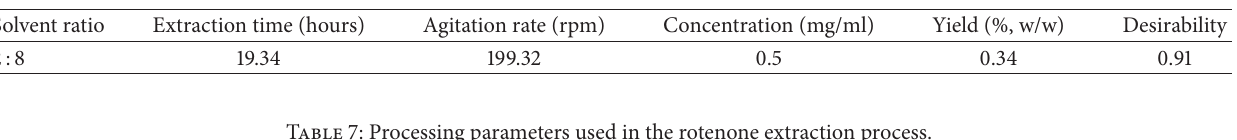
Table 6: Processing parameters used in the rotenone extraction process.